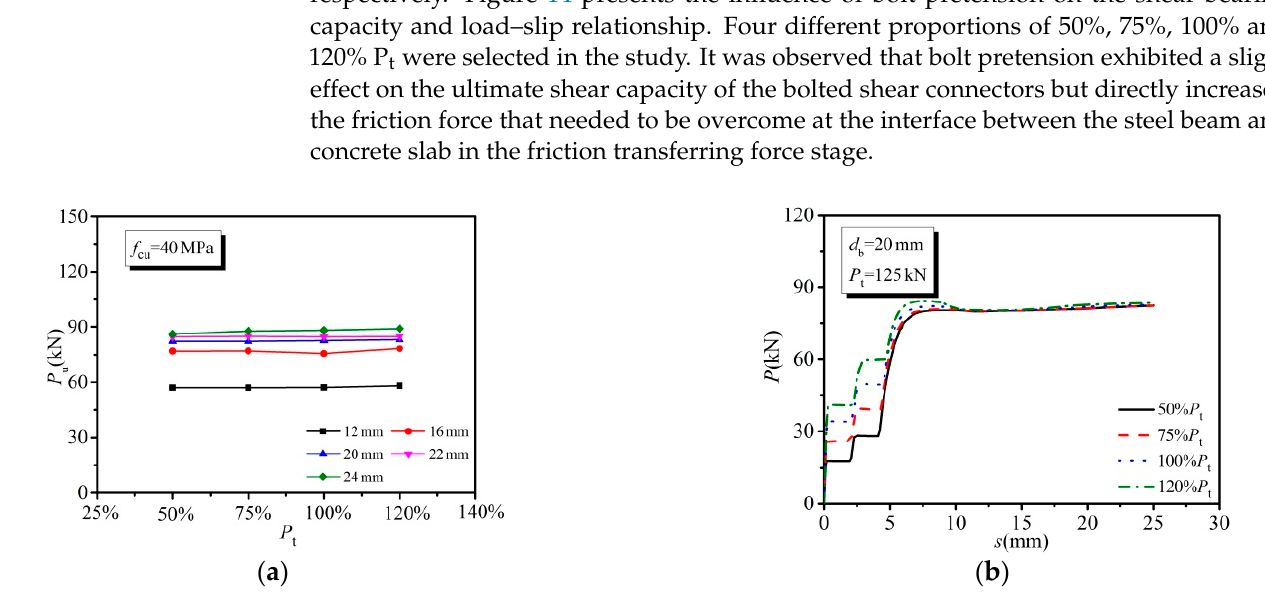
Figure 14. Effect of bolt pretension: ( a ) shear bearing capacity; ( b ) load–slip relationship.